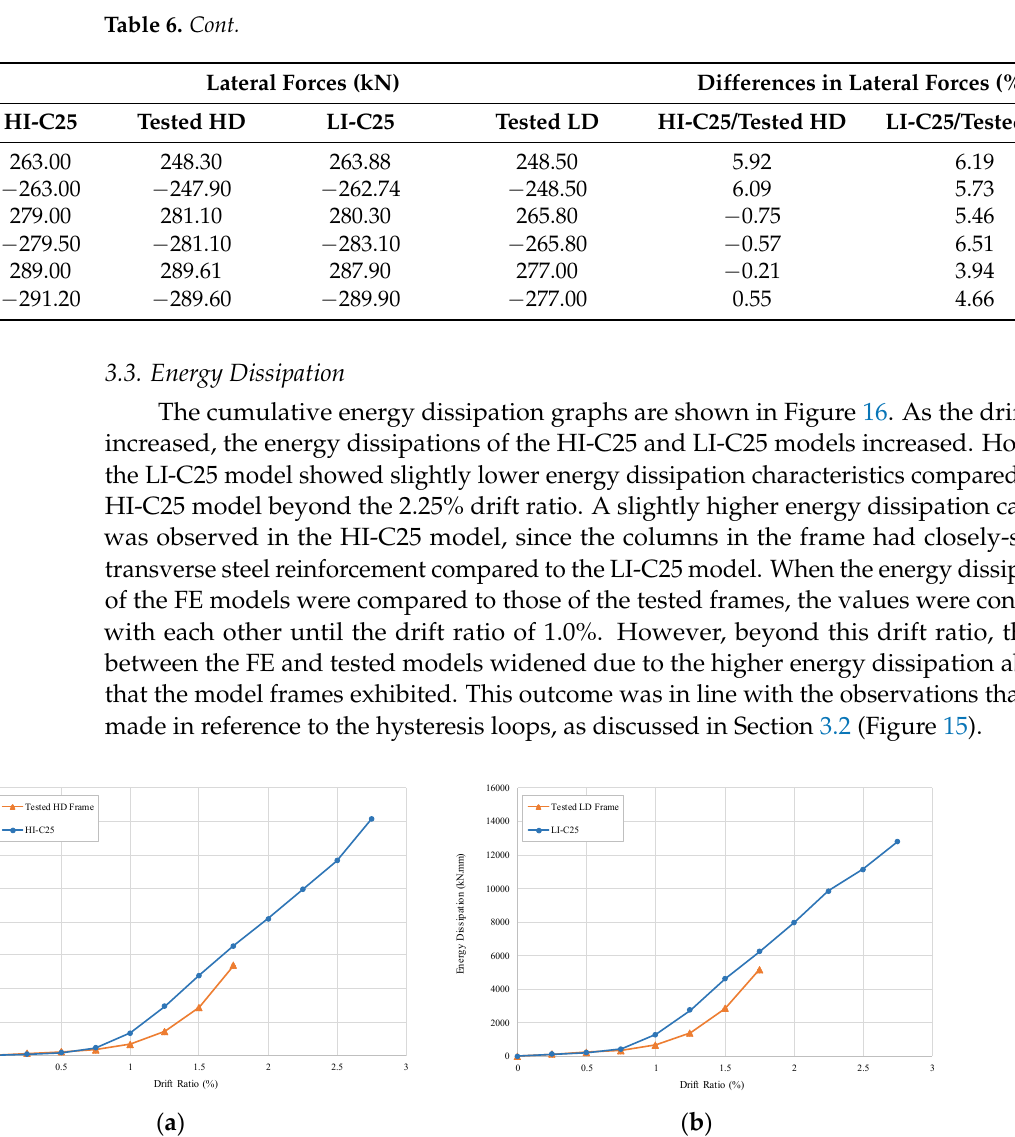
Figure 16. Energy dissipation of the tested frames and models: ( a ) HI-C25; ( b ) LI-C25.